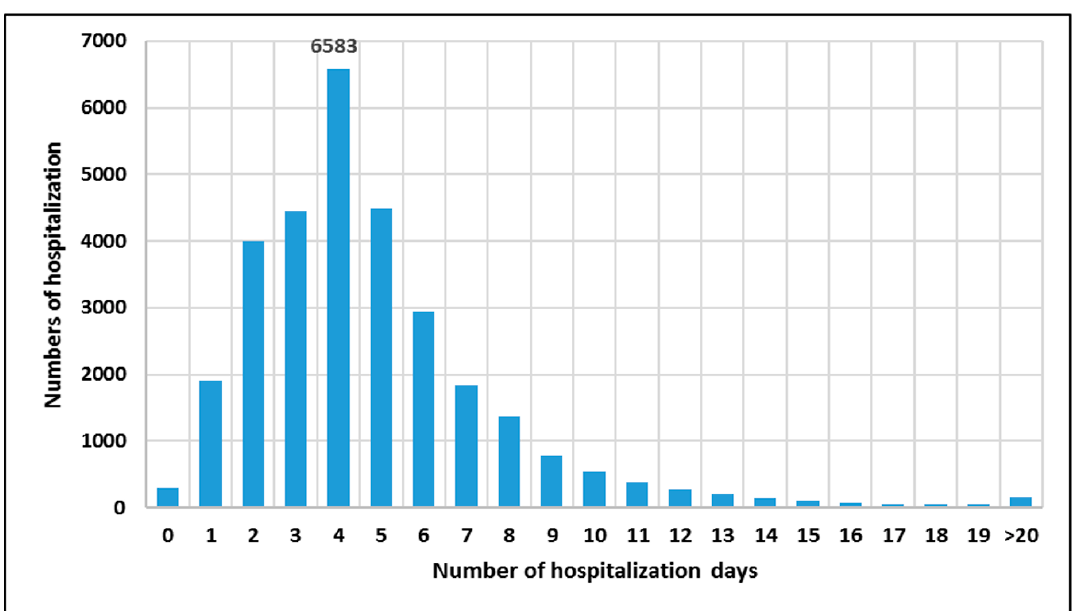
Figure 1. Length of hospitalisation (in days) of hospital readmissions reported for patients covered by CCMI.